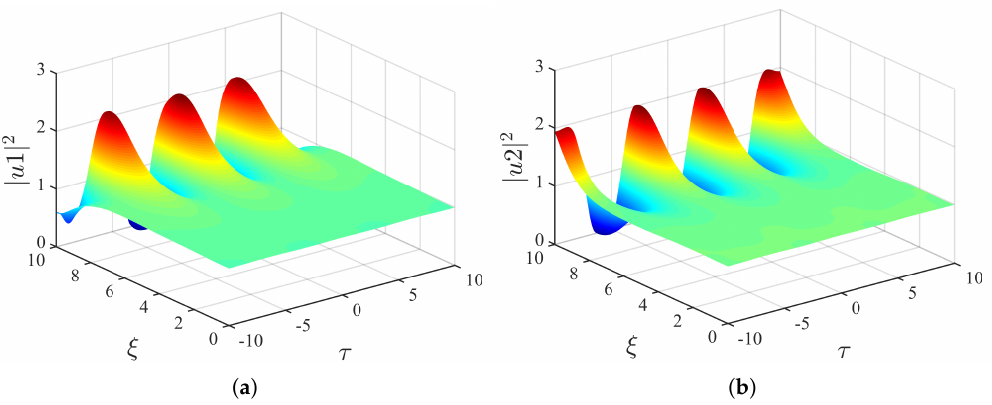
Figure 22. The MI evolution in the bar ( a ) and cross ( b ) channels in the normal-GVD regime ( σ = − 1) for the amplitudes of the CW components A 1 = A 2 = 1 and perturbation parameters a 0 = 0.002, ω 0 = 1. Other parameters are α = 2, Γ = 1, ρ = 0.01, χ = 0.001 and κ = 1.